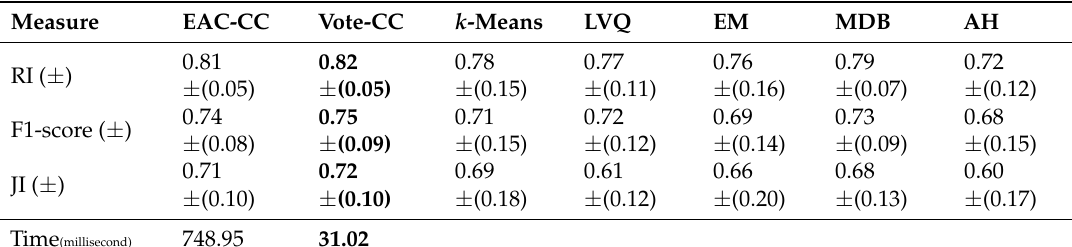
Figure 2. Examples of tissue regions detection in ten haematoxylin and eosin (H&E) images—from left, the original image, gold-standard, Evidence Accumulation Consensus (EAC-CC), Vote-CC and the individual clustering methods after superpixel segmentation. Black, white, magenta and green colours correspond to the segmentation lines, background, epithelium and stroma regions, respectively. Table 1. Performance evaluation of the Evidence Accumulation Consensus (EAC-CC) and Vote-CC frameworks compared against five individual clustering approaches in terms of mean Rand Index (RI), F1-score and Jaccard Index (JI) along with standard deviations ( ± ) across the forty-five images. The best results (Vote-CC method) are marked in bold